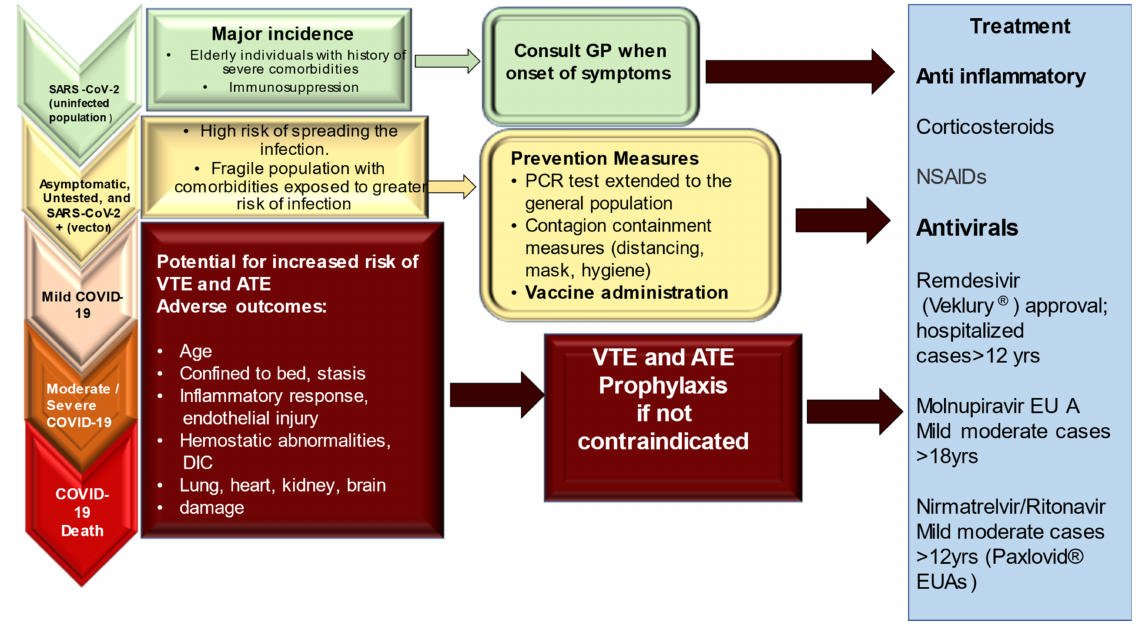
Figure 8. The infection from SARS-CoV-2 caused a variability in the manifestation of the disease. This explains the different population rates of infection and the distinct mortality rates of manifest cases in various regions and countries. Inflammatory response, increased age, and bed rest, which are most frequently seen in severe coronavirus disease 2019 (COVID-19), may contribute to thrombosis and adverse events resulting from multiorgan involvement. FDA timeline of antivirals approval and EUAs. Veklury ® EUA was formalized in January 2020. Its definitive approval occurred in arterial thromboembolism.; COVID-19, coronavirus disease 2019; DIC, disseminated intravascular coagulation; EUA: Emergency Use Authorization; FDA: Food and Drug Administration; NSAIDs, non-steroid anti-inflammatory drugs; SARS-CoV-2, severe acute respiratory syndrome-coronavirus-2; VTE, venous